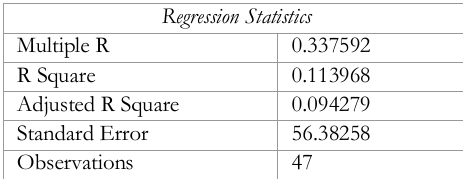
Table 3: Regression statistics for ease of